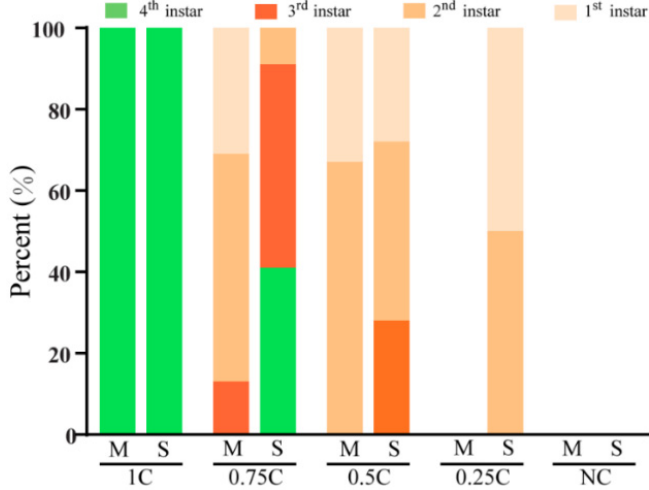
Figure 3. Proportions of larvae alive in each instar. Instar proportions of Mythimna separata (M) and Spodoptera frugiperda (S) larvae on diets containing different cholesterol concentrations on the 12th day.